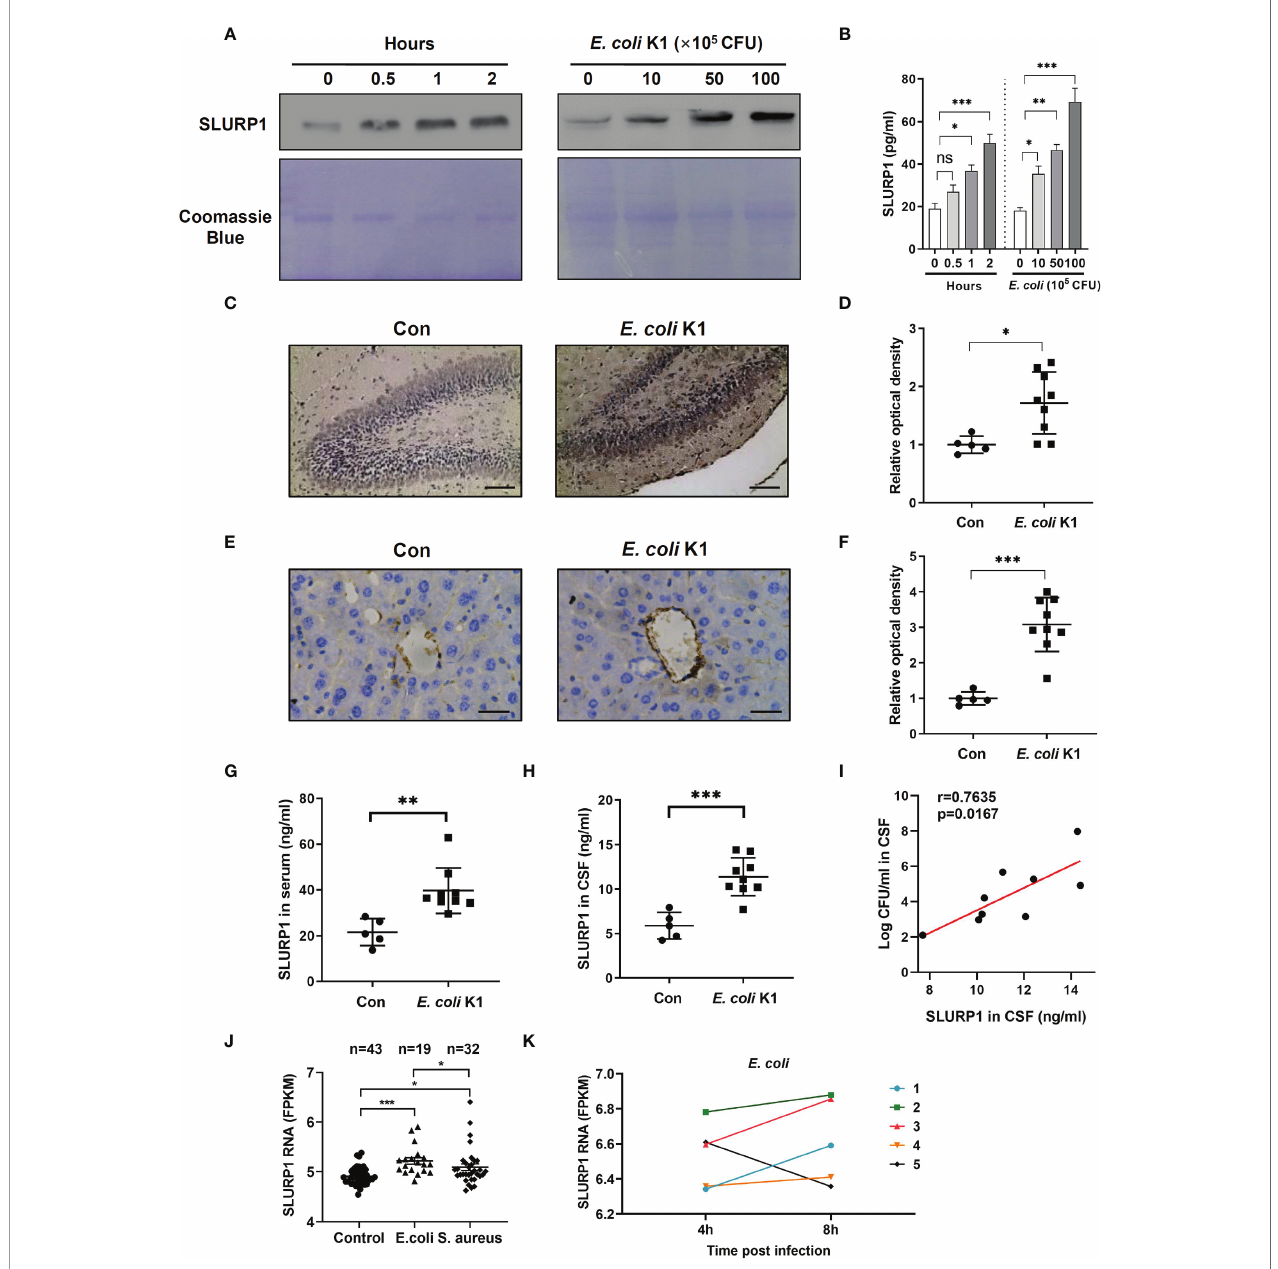
FIGURE 1 | E coli K1 enhances SLURP1 secretion. (A, B) Immunoblot analysis (A) and ELISA (B) showed the SLURP1 release in the culture supernatant of HBMEC infected with E coli K1 (5 × 10 6 CFU) at different time intervals (0 – 2 h, left panel), or infected with various doses of E coli K1 (0 – 1 × 10 7 CFU) for 2 h (right). (C) Immunohistochemical staining of SLURP1 in the hippocampus sections of mice infected with or without E coli K1, scale bar = 200 m m. (D) The semiquantitative results of immunohistochemical staining of SLURP1, shown as fold change relative to control. (E) Immunohistochemical staining of SLURP1 in the cortex sections from mice challenged with or without E coli K1, scale bar = 40 m m. (F) Semiquantitative analysis of immunohistochemical staining of SLURP1, shown as fold change relative to control. (G, H) Quanti fi cation of SLURP1 secretion in the serum (G) or CSF (H) of mice infected with or without E coli K1. (I) Correlation analysis of SLURP1 levels and E coli K1 counts in the CSF. (J) Relative SLURP1 transcription levels (FPKM) among patients with E coli or S. aureus sepsis. (K) Change of relative SLURP1 transcription levels (FPKM) of fi ve patients in 4- or 8-h post- E. coli infection. FPKM, fragments per kilobase of exon per million reads mapped. Data are presented as mean ± SEM. The immunoblots and immunohistochemical results are representative of two independent experiments (A, C, E) . The data are displayed as the mean ± SEM from two independent experiments (B, D, F, G – I) . * p < 0.05; ** p < 0.01; *** p < 0.001 by one-way ANOVA followed by Bonferroni post-hoc test (B, J) and Student ’ s t -test (D, F – H) . Correlation analysis was performed using Pearson and Spearman correlation tests. ns, not signi fi